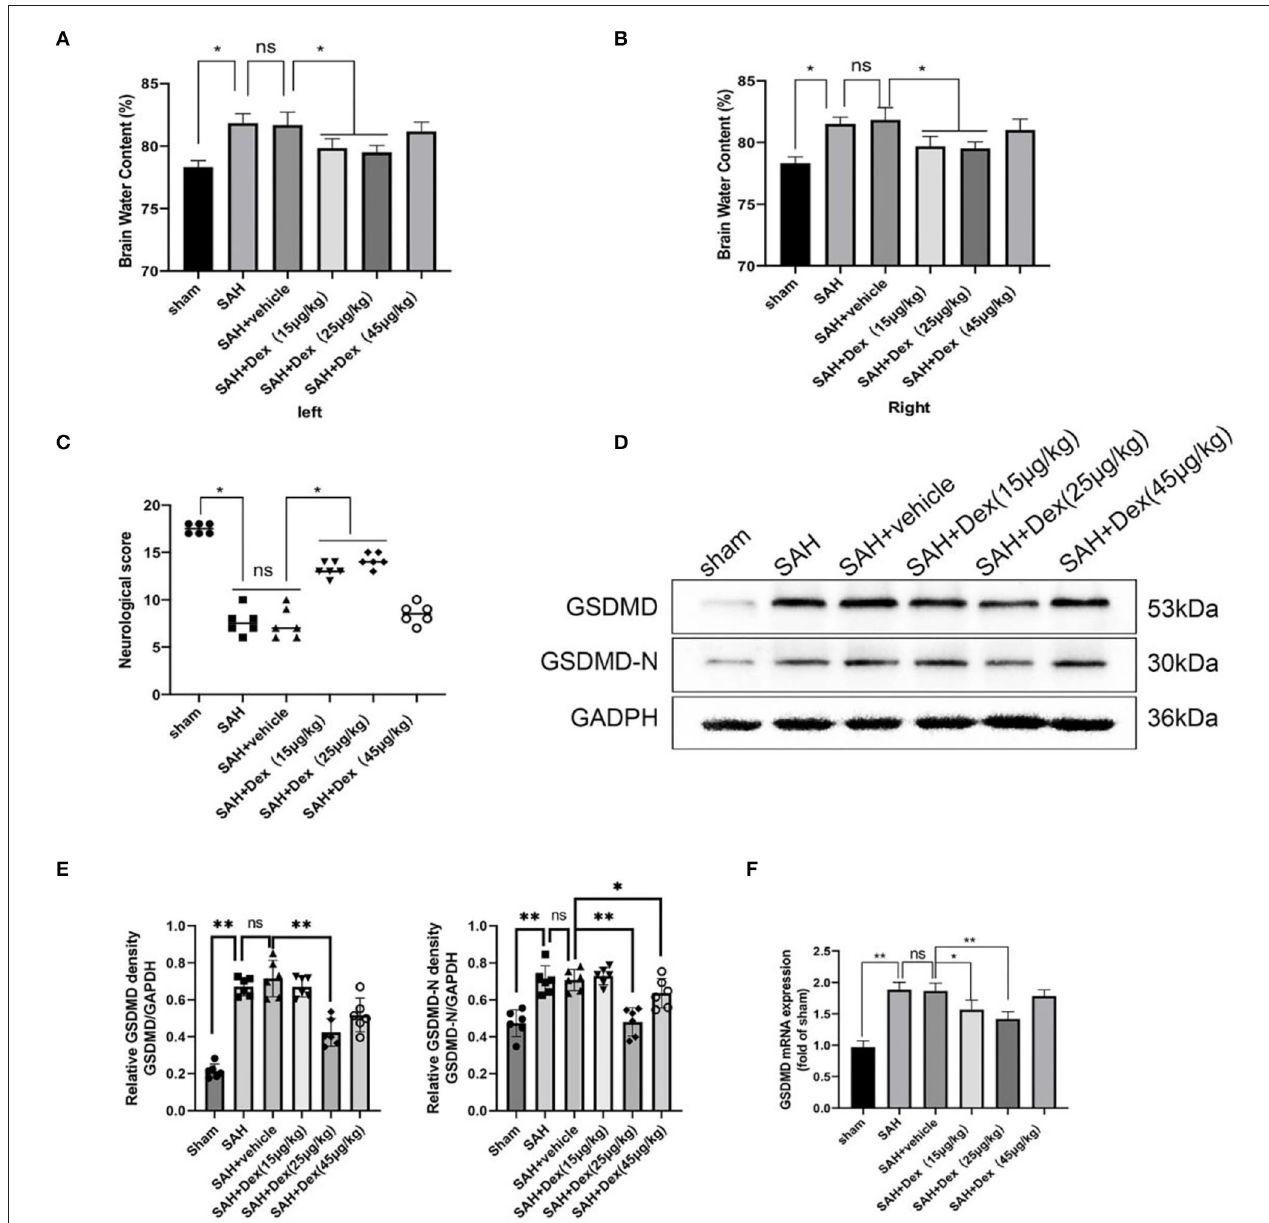
FIGURE 4 | Dex attenuates short-term neurological deficit and brain edema at 24h after SAH. (A,B) Quantification of brain water content 24h after SAH. (C) Neurobehavioral deficits 24h after SAH. Effect of 25 µ g/kg dosage of Dex on the protein levels of GSDMD, GSDMD-N (D,E) and GSDMD mRNA expression (F) . Values are expressed as the mean ± SD, n = 6 in each group. * p < 0.05, ** p < 0.01, ns, no